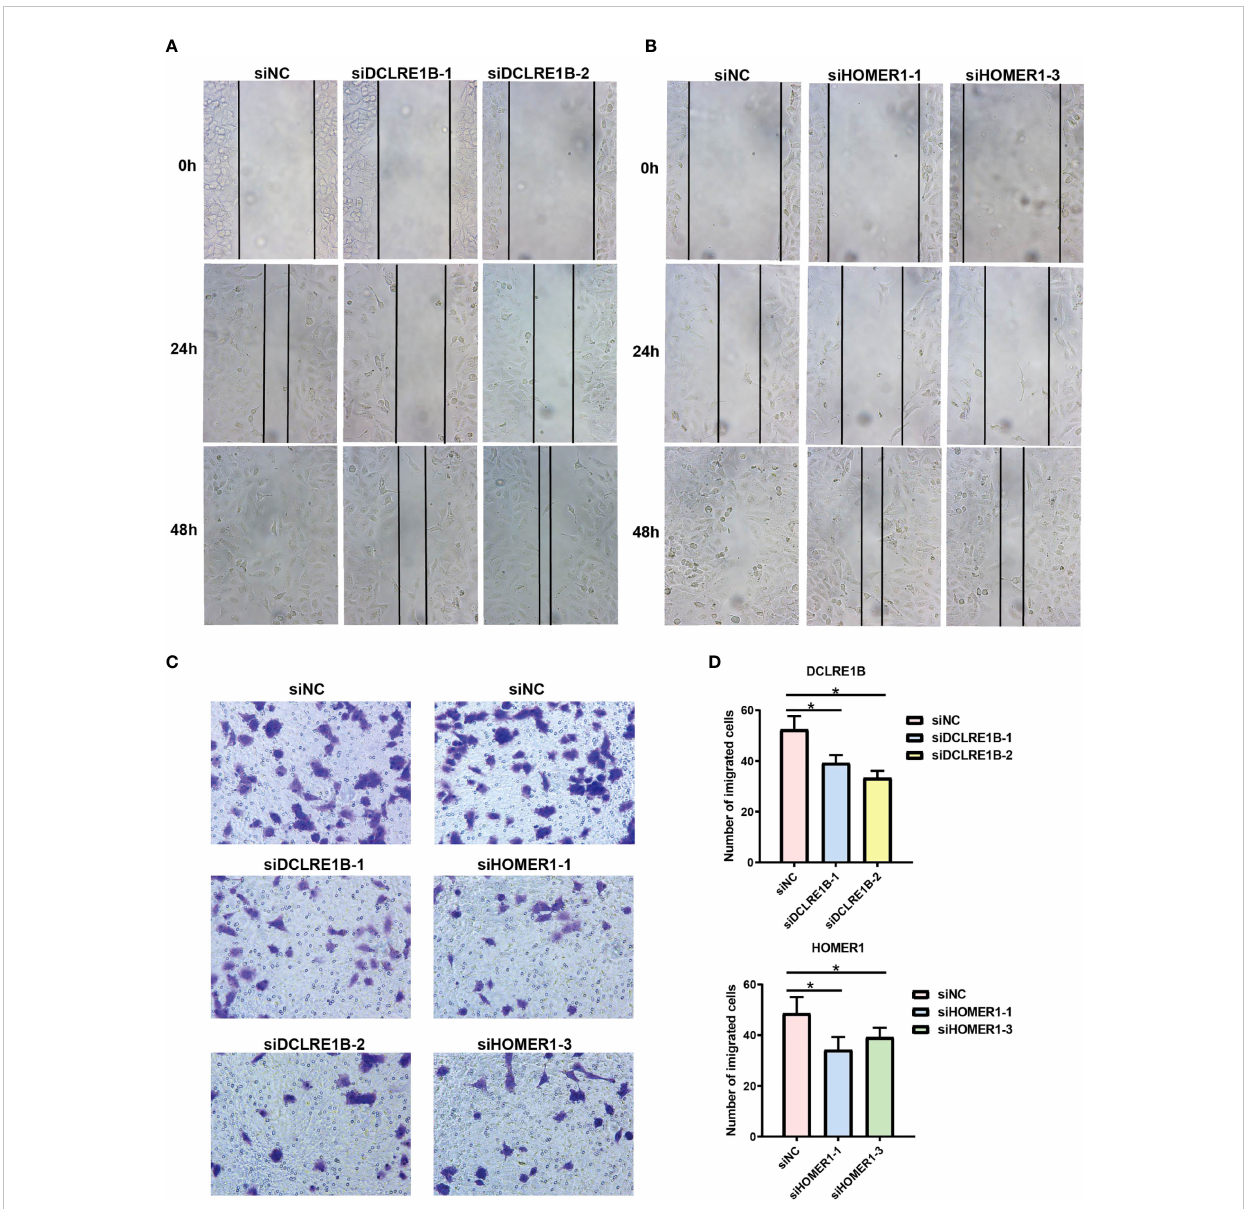
FIGURE 14 Validation of cell migration and invasion for DCLRE1B and HOMER1 in LUAD cell line A549. A549 cells were transiently transfected with siRNAs (siDCLRE1B-1, siDCLRE1B-2, siHOMER1-1 or siHOMER1-3) or with its corresponding negative control (siNC). (A, B) Wound healing assay was used to measure cell migration. (C, D) Transwell assay was used to measure cell invasion. Representative images were shown on the right. The data were presented as the mean ± standard deviation. ∗ P <